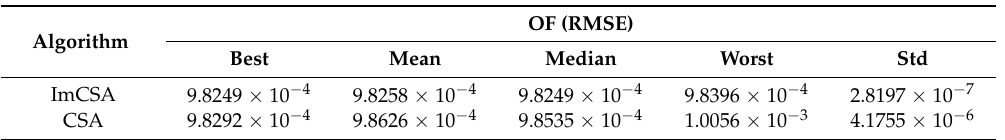
Table 4. Statistics of the OF (RMSE) values for the DDM of RTC France silicon solar cell using the proposed ImCSA and CSA.